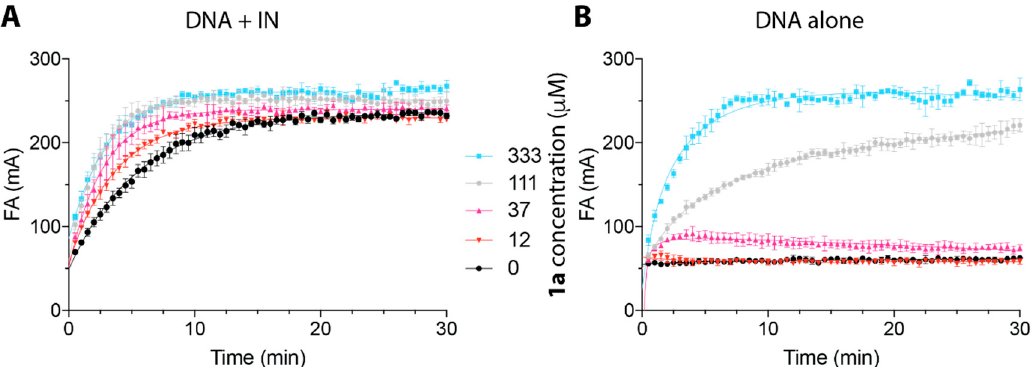
Figure 2. The binding properties of peptide 1a to IN–DNA complex and DNA alone evaluated over time by fluorescence anisotropy or in the presence of IN (400 nM) preincubated with 1a at the indicated concentrations ( A ) or in the absence of IN ( B ). Different concentrations of peptide 1a are color-coded: 0 µM in black; 12 µM in red; 37 µM in pink; 111 µM in gray; 333 µM in blue. Recently, allosteric HIV-1 IN inhibitors (ALLINIs) have been identified, which induce higher- order, aberrant IN multimerization in vitro and in virions, and inhibit proper virus particle maturation [27–35]. Using a homogeneous time-resolved fluorescence resonance energy transfer (HTRF) assay [36], we found that unlike a representative ALLINI ( BI-1001 ), 1a did not induce higher- order IN multimerization, suggesting an allosteric IN inhibition mechanism that differs from that used by ALLINIs (Figure 3) [27].